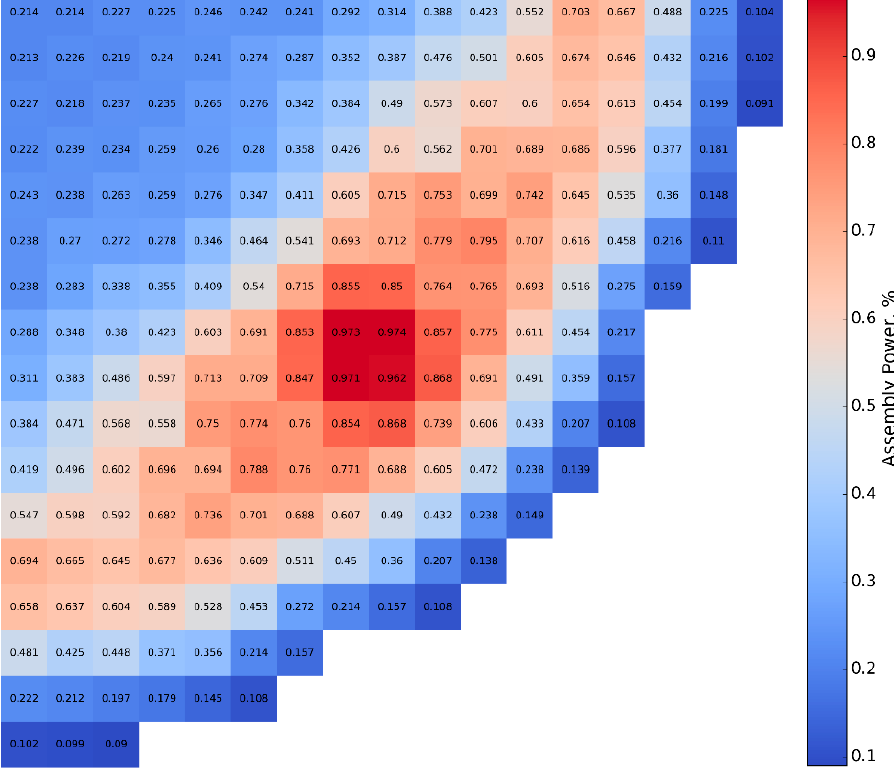
Figure 25. Serpent’s full core assembly power profile.